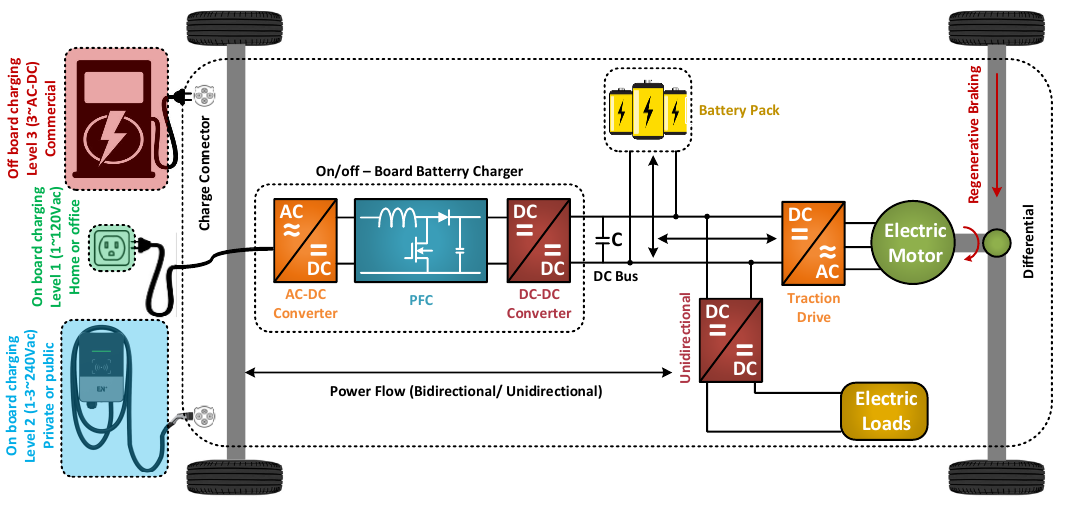
Figure 13. The EV drivetrain with converters connected with a charging system.